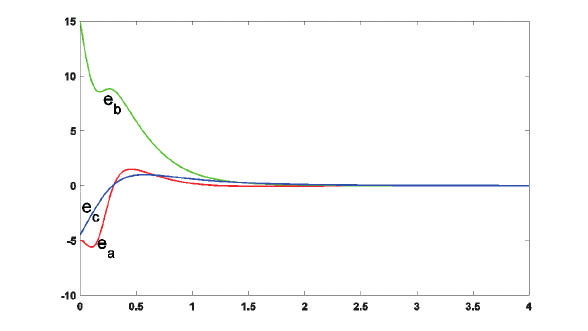
Fig. 2: The errors of the drive system parameters